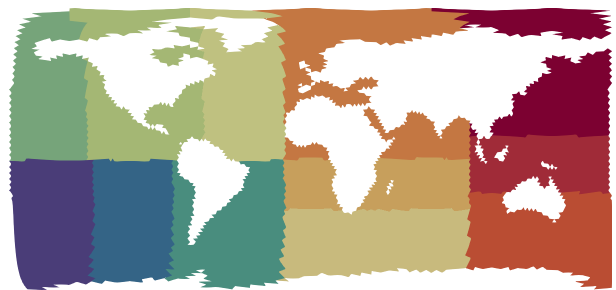
Figure 6. The 160km grid decomposed into 12